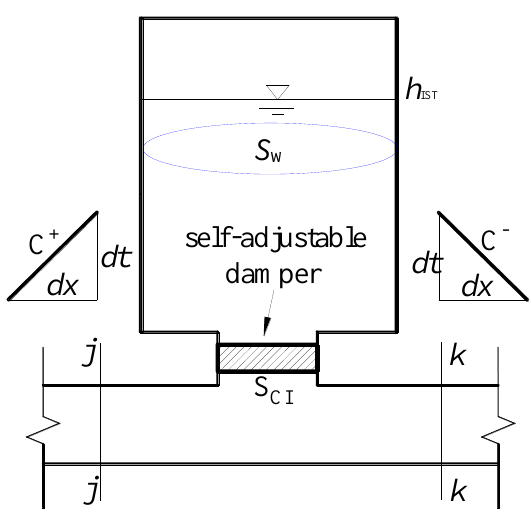
Figure 6. Illustration of an intelligent self-controlled surge tank.